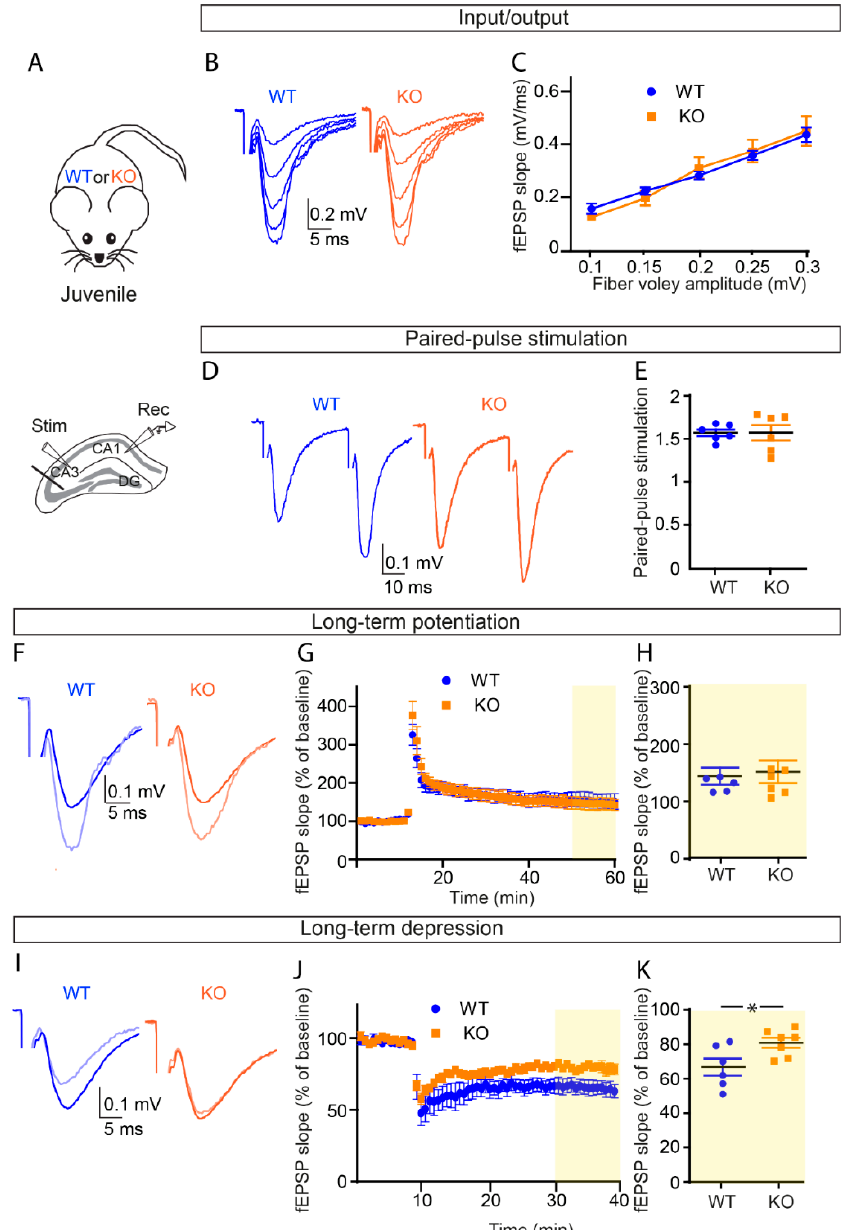
Figure 1. Selective impairment in long-term depression with no change in basal excitatory synaptic transmission and long-term potentiation in juvenile OPHN1-deficient mice. ( A ) Scheme of the hippocampus illustrating the arrangement of the stimulating electrode, to activate the Schaffer collaterals, and of the neuronal recording electrode (extracellular), to record fEPSPs evoked by the stimulation in the CA1 area of Ophn1 KO mice (KO) juvenile mice or WT littermate. ( B , C )